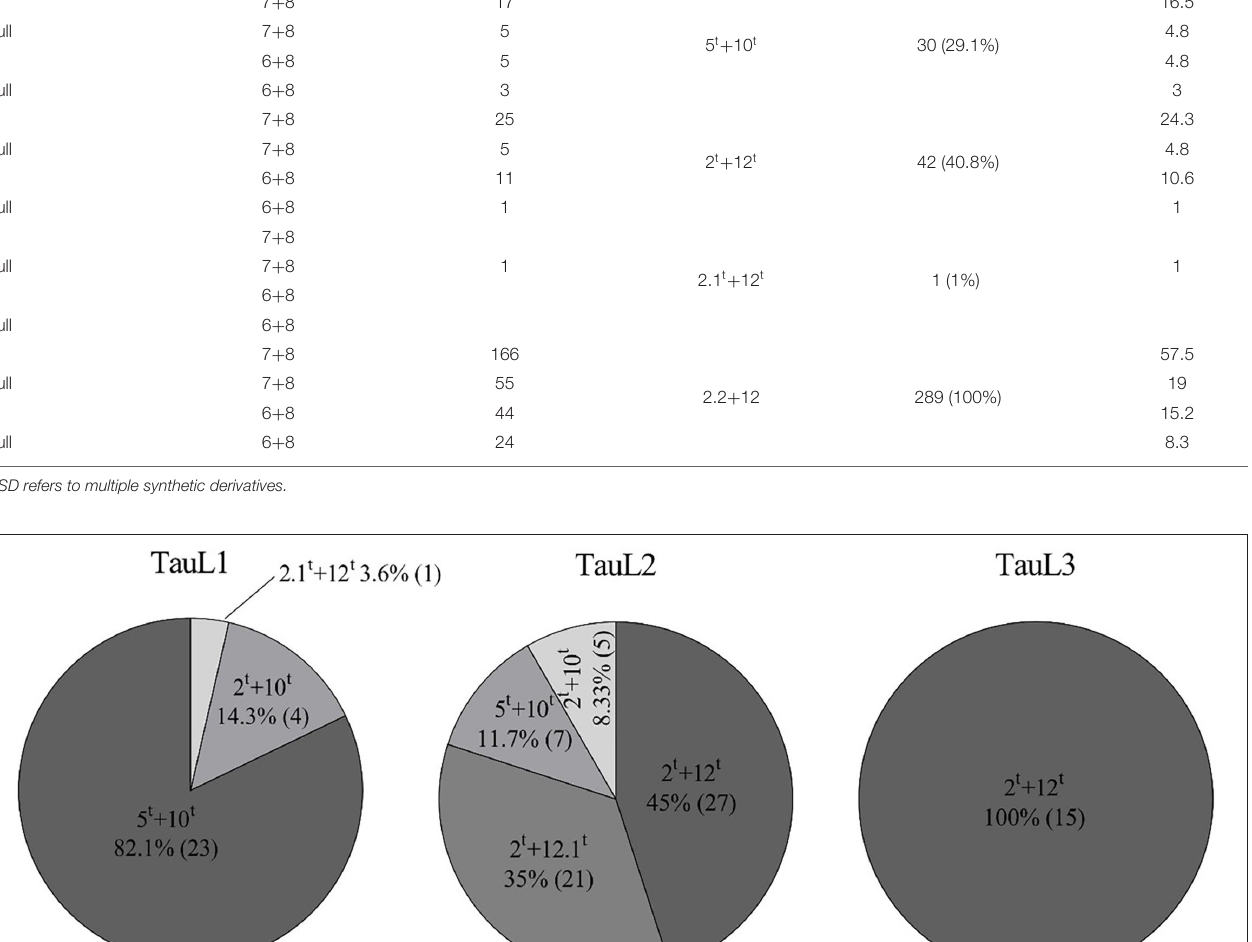
significantly higher than N61 and 13 and 14 comparable, six and 24 lines were significantly lower than N61 respectively ( Figure 4